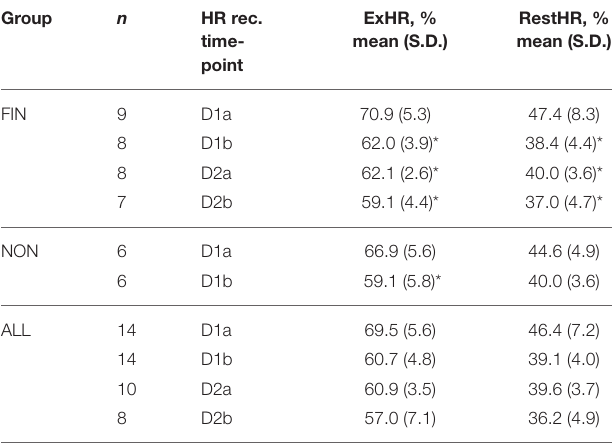
TABLE 3 | Average exercise intensity and rest quality.